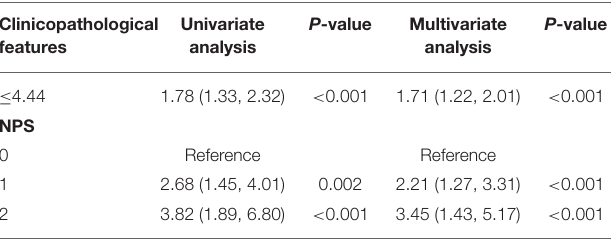
the relationships with correlation with some clinicopathological